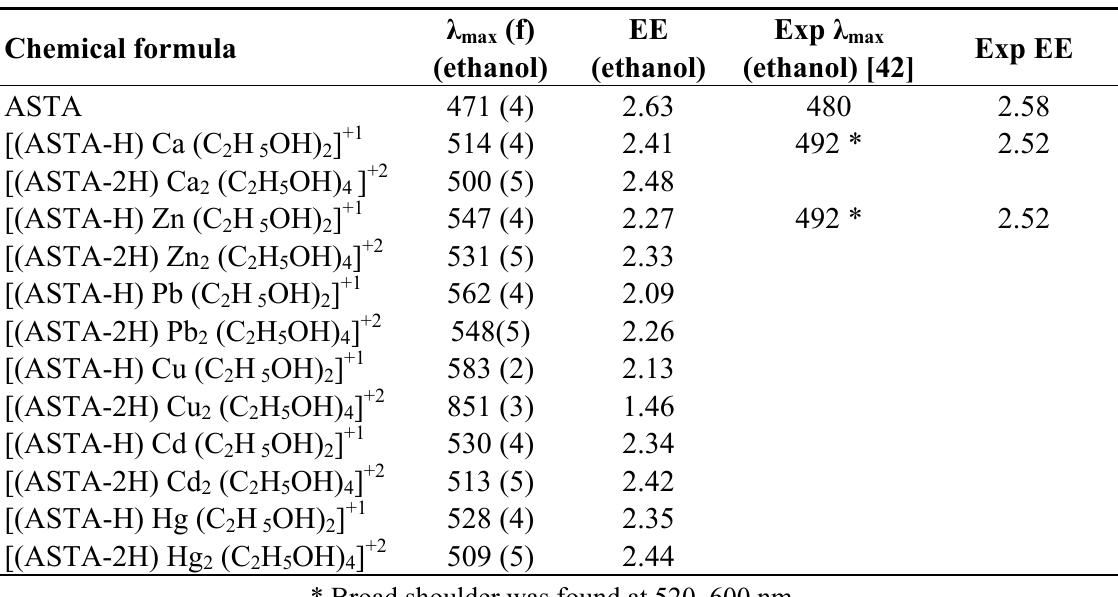
, in nm and oscillator strength max